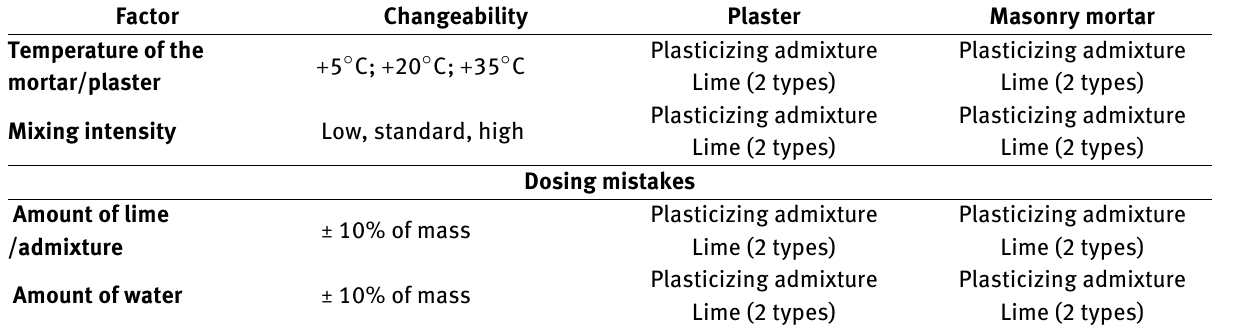
Table 2: The research